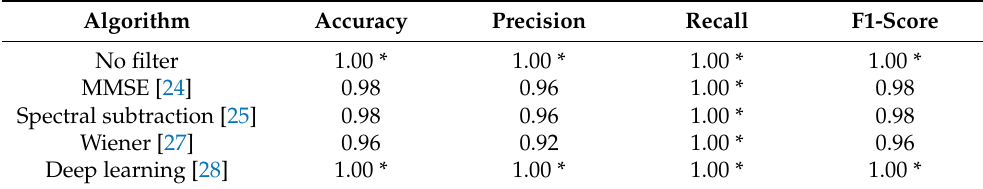
Table 9. White Noise SNR 5. * is the best result for each particular measure.